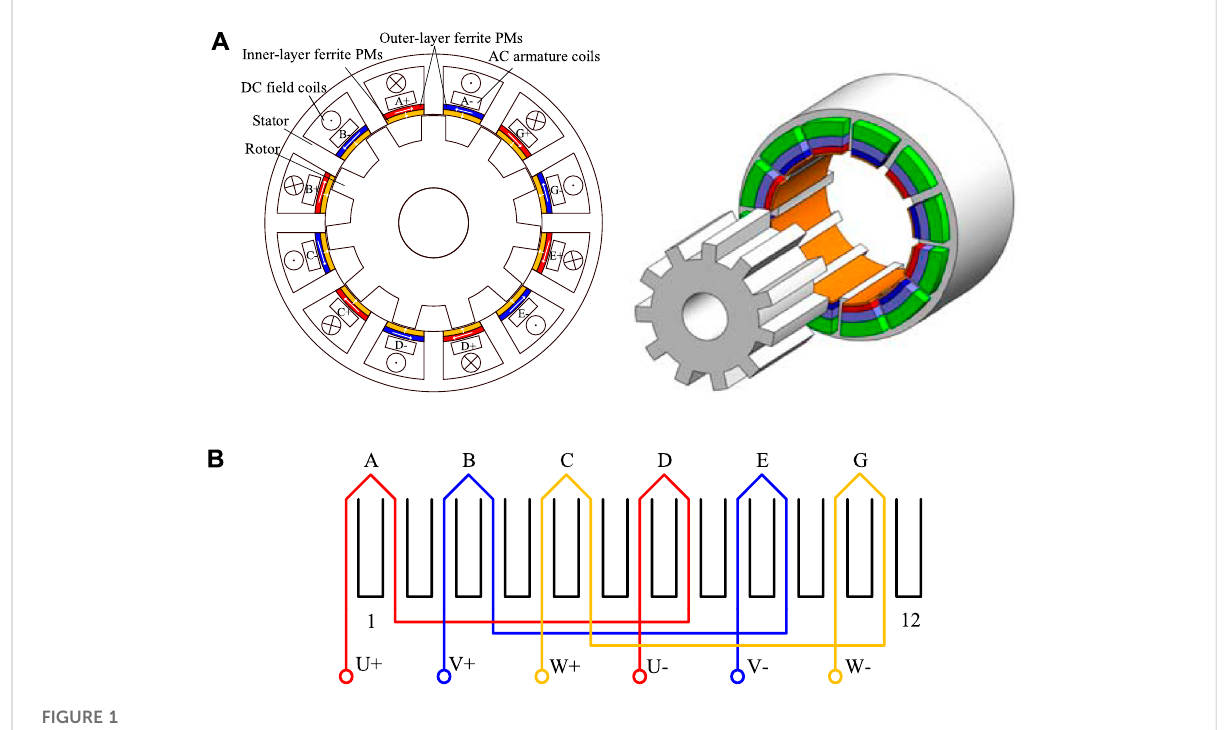
FIGURE 1 (A) Structure of the proposed HRM. (B) Armature winding